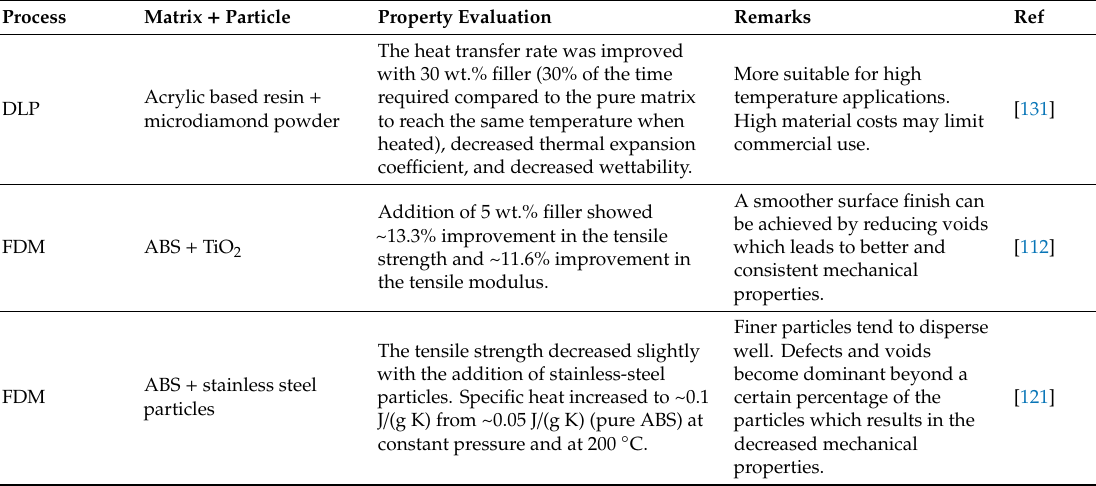
Table 2. A summary of di ff erent particle reinforcements into polymer matrices.